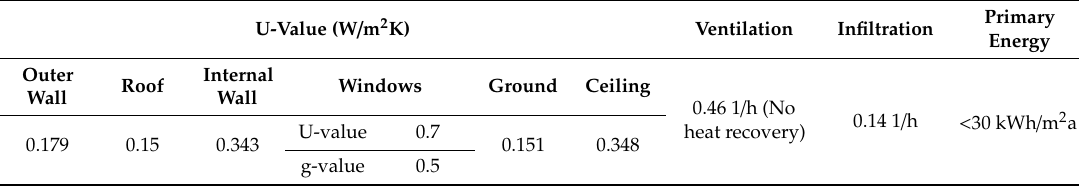
Table 1. Building parameters overview of the Sonnenhaus standard single-family house.